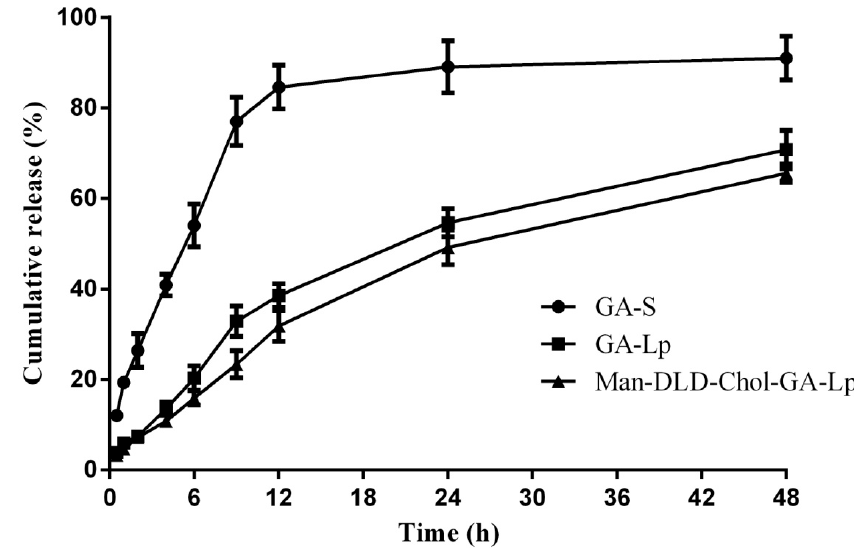
Figure 4. In vitro cumulative release of GA-S, GA-Lp and Man-DLD-Chol-GA-Lp. Table 2. Fitting coefficient of GA-S, GA-Lp and Man-DLD-Chol-GA-Lp in different release models. Sample